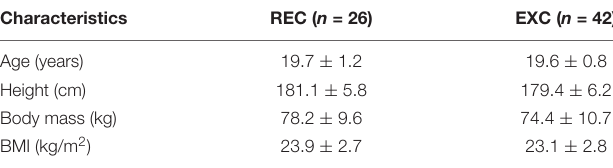
TABLE 1 | Basic characteristics of the